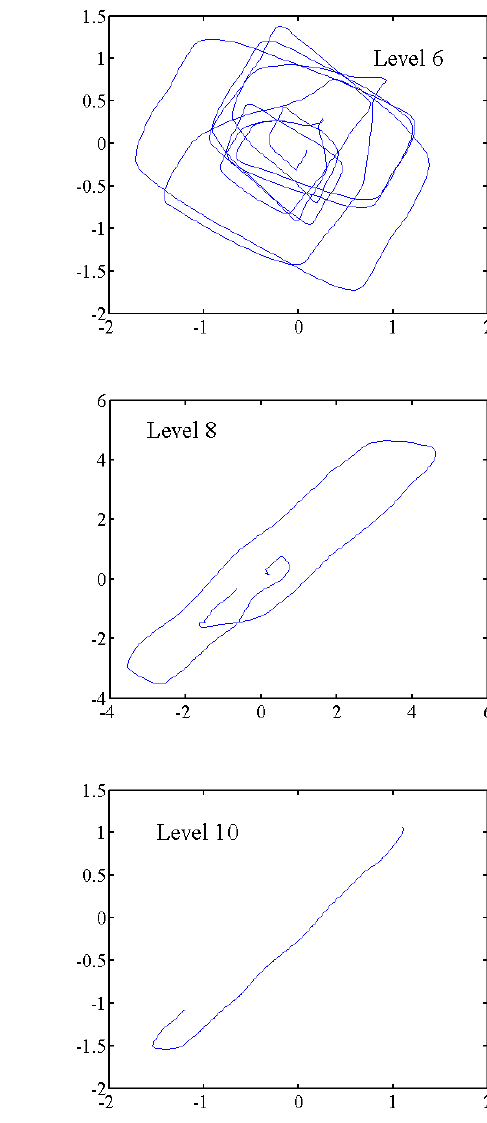
Figure 7. Time delay construction ( x n and x n − d ) for each component (level 1–level 10) using wavelet decomposition of wind speed time series.